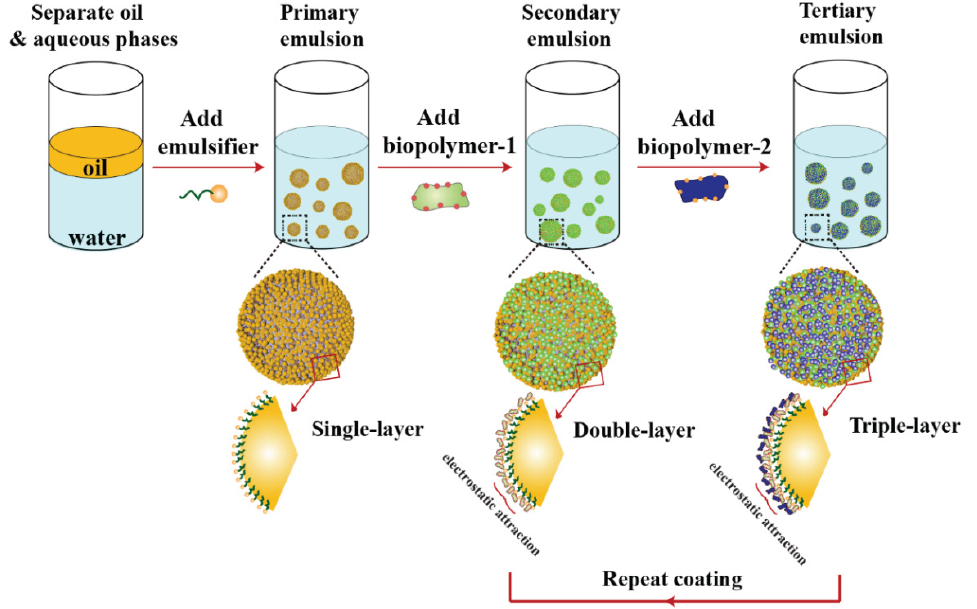
Figure 5. The interfacial composition of the droplets in an oil-in-water emulsion may be altered after homogenization by electrostatic deposition methods. In this case layers of charged biopolymers are deposited onto oppositely charged droplets.